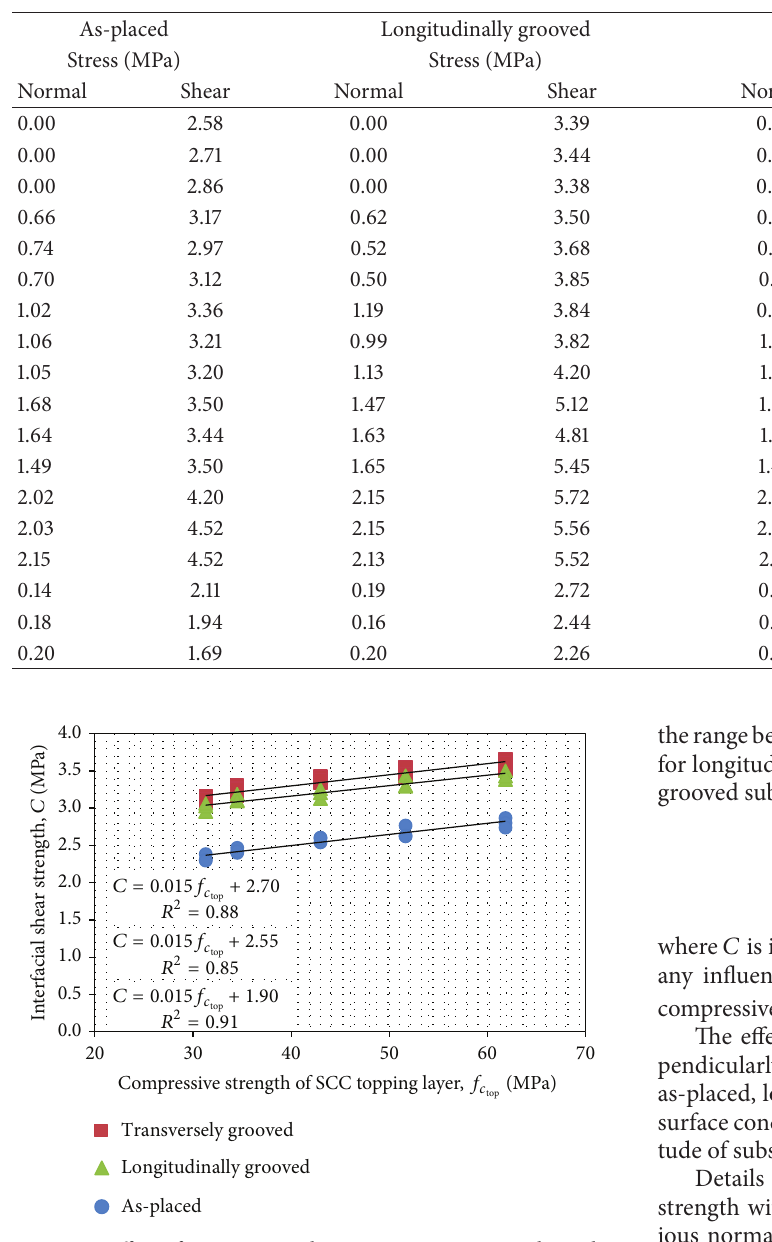
Table 6: Test results on interfacial shear bond strength with different substrate surface condition and various normal force which is acting perpendicularly to the interface area.